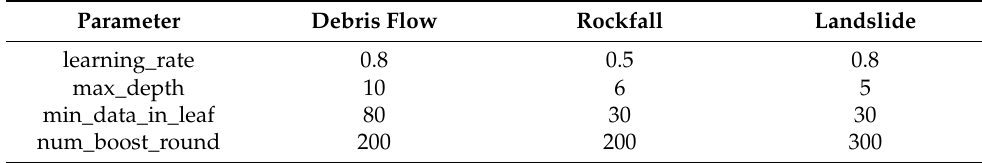
Table 2. Parameter settings of TBMM for three types of mass movement.